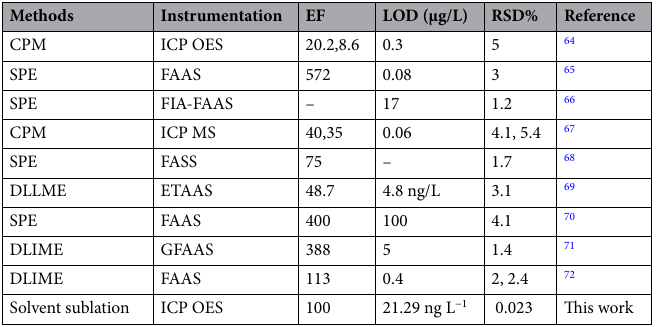
Table 7. Comparative data from some recent studies on preconcentration-separation of palladium